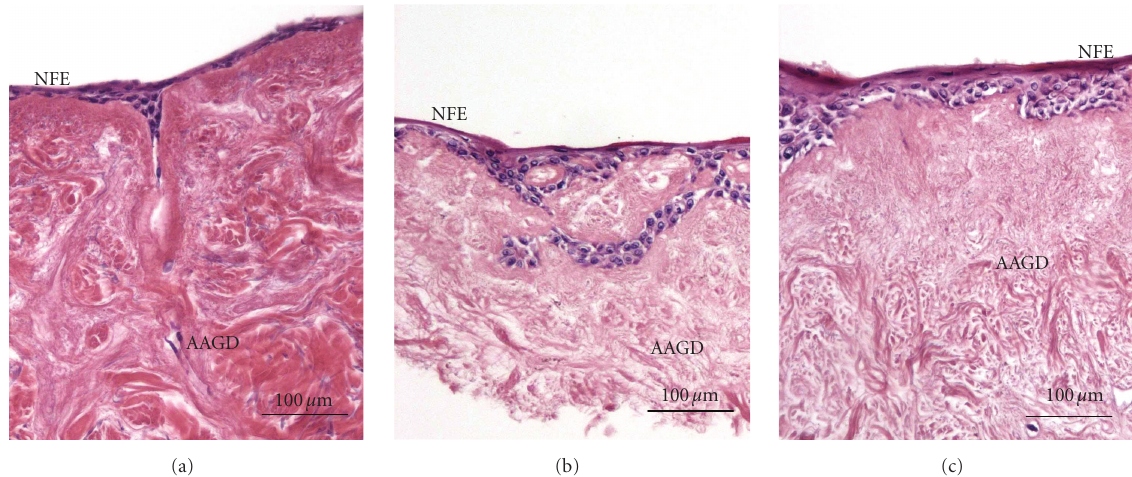
Figure 6: Histomorphological analysis performed on the biosubstitute sections obtained from primary culture keratinocytes at (a) 7 days, (b) 14 days, (c) 21 days post nebulization. Original magnification: 10x. AAGD: alloplastic acellular glycerolized dermis; NFE: newly formed epithelium.